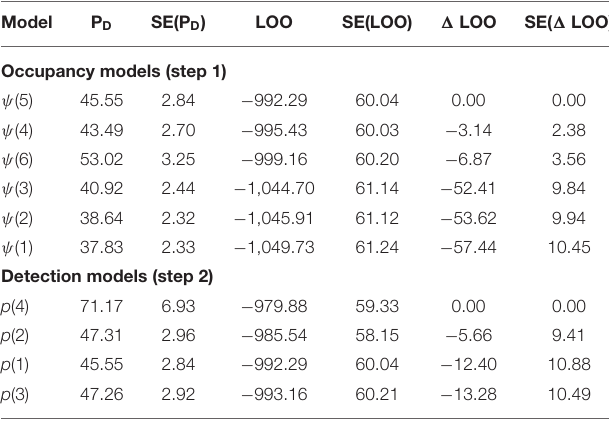
TABLE 2 | Model selection of candidate occupancy models (step 1) and detection models (step 2).